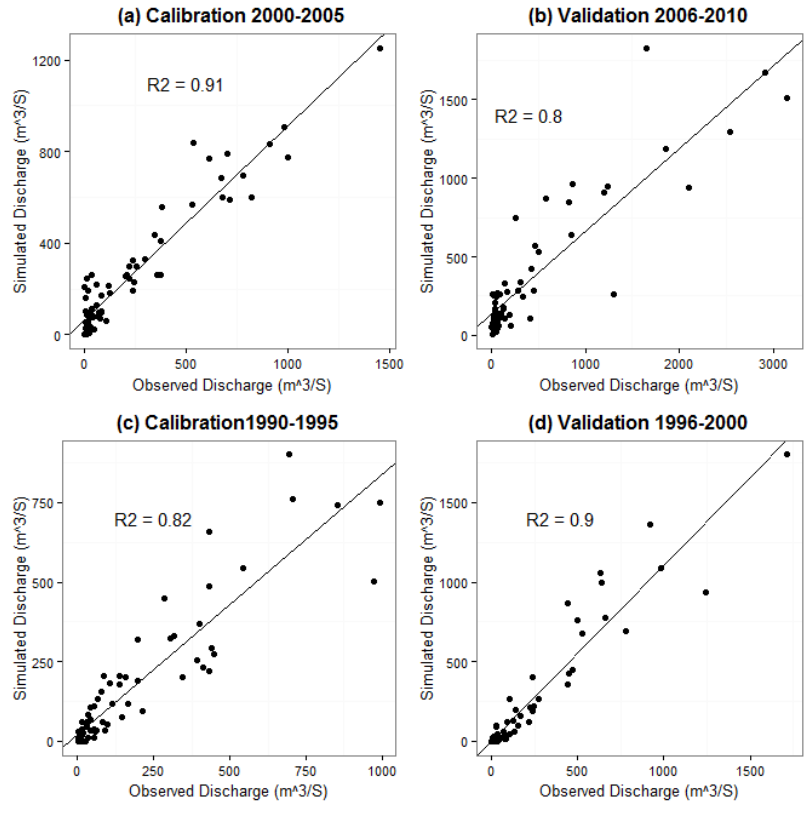
Figure 8. Simulated Discharge vs. Observed Discharge. Table 6. Model performance During the Period 2000–2010.